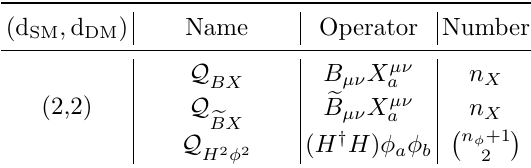
Table 9 . Dimension-four ∆ B = ∆ L = 0 operators in DSMEFT. The first column gives the dimensions of the SM and DM part of the operator, and the fourth column is the number of